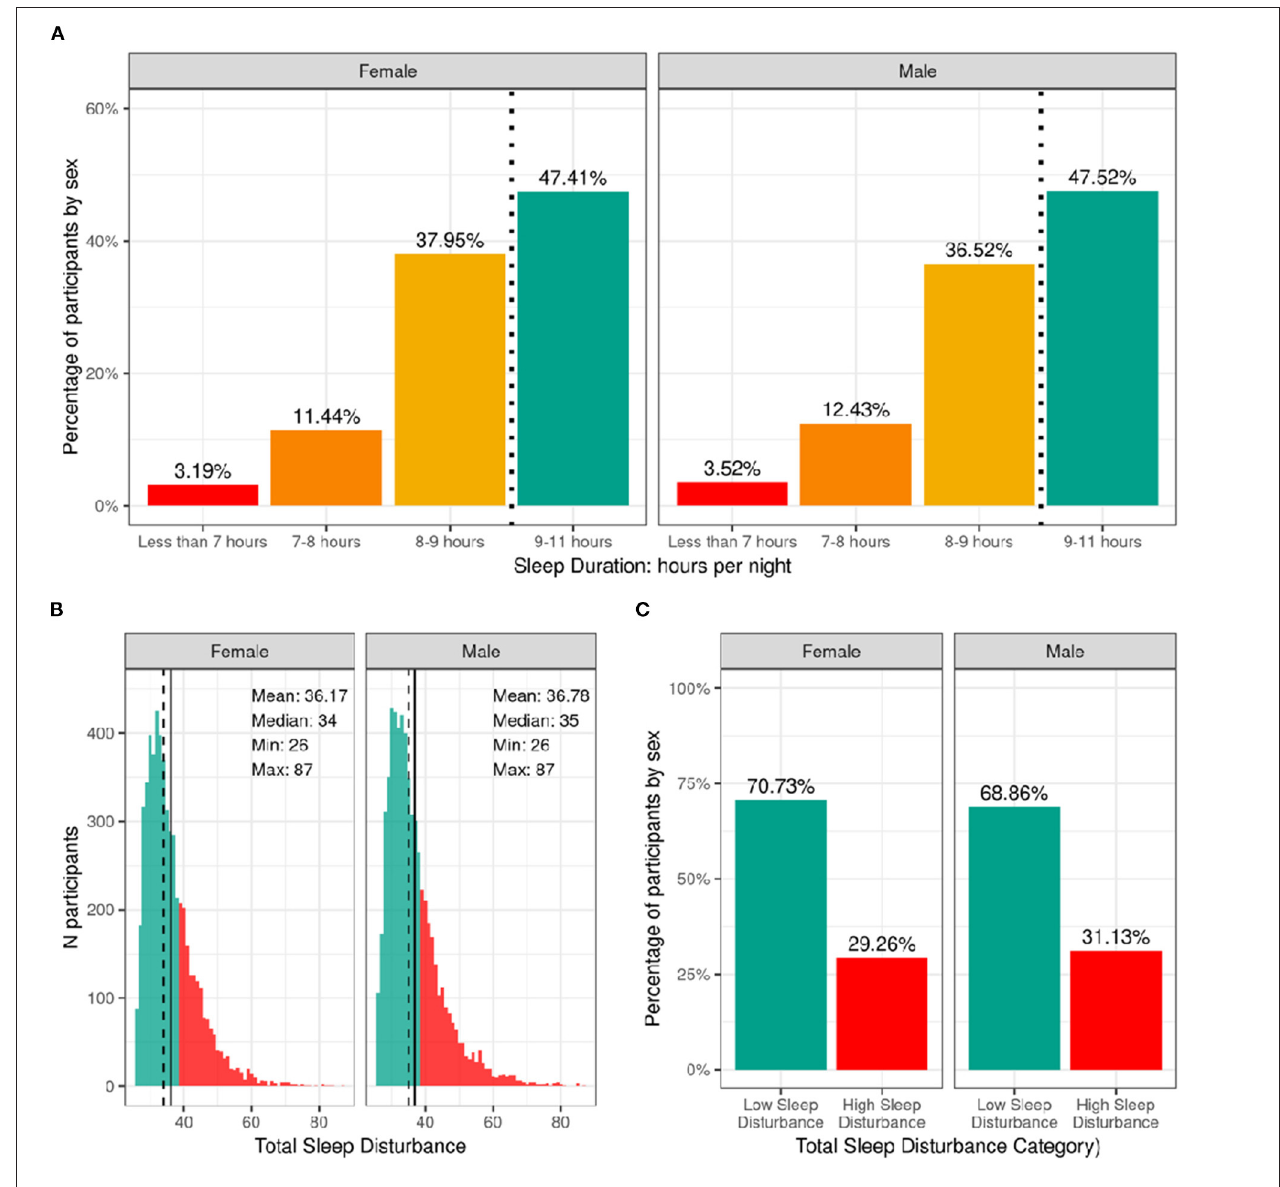
FIGURE 6 | Distribution of participants sleep duration and disturbances. (A) Percentage of participants stratified by sex assigned at birth who indicated their average sleep duration to be < 7h (red), 7–8h (orange), 8–9h (yellow), or 9–11h (green). (B) Continuous distribution of participant’s scores on the Sleep Disturbance Scale for Children (SDSC) stratified by sex assigned at birth. Participants scoring < 39 were deemed to have low sleep-wake disturbance (green) and those scoring > 39 wered deemed to have high sleep-wake disturbance (red). (C) Percentage of participants (stratified by sex assigned at birth) who experienced low (green) or high sleep-wake disturbance